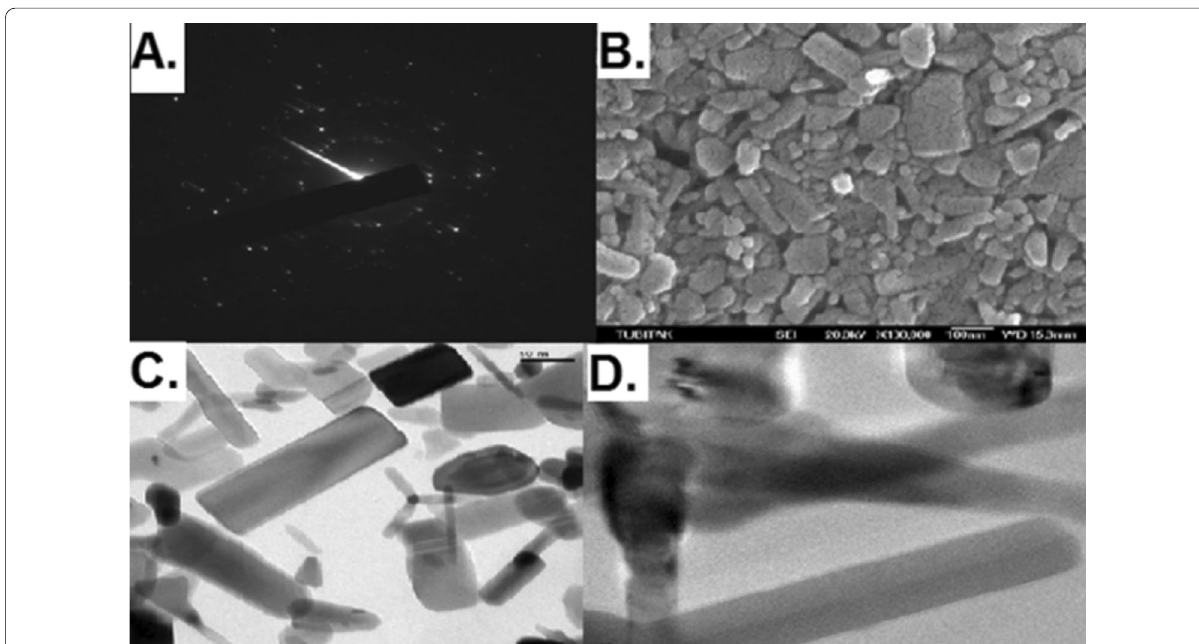
Fig. 1 Electron diffraction pattern image of zinc oxide nanorods ( A ), SEM image of zinc oxide NP at a 100.000 magnification (the bar indicates a length of 100 nm) ( B ), TEM image of zinc oxide NP (the bar indicates a length of 100 nm) ( C ), TEM image of zinc oxide NP (the bar indicates a length